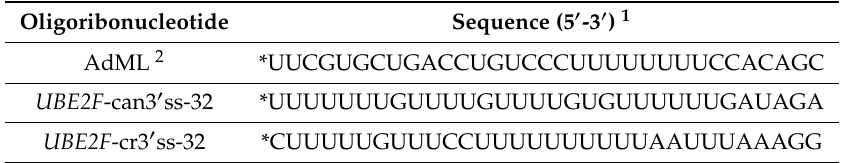
Table 1. RNA probes for non-isotopic EMSA. 1 Asterisks denote biotin. 2 AdML RNA is derived from the adenovirus major late 3 (cid:48) ss and was previously shown to bind recom binant PUF60 [11]. The last nucleotide of each EMSA probe is at the first exon